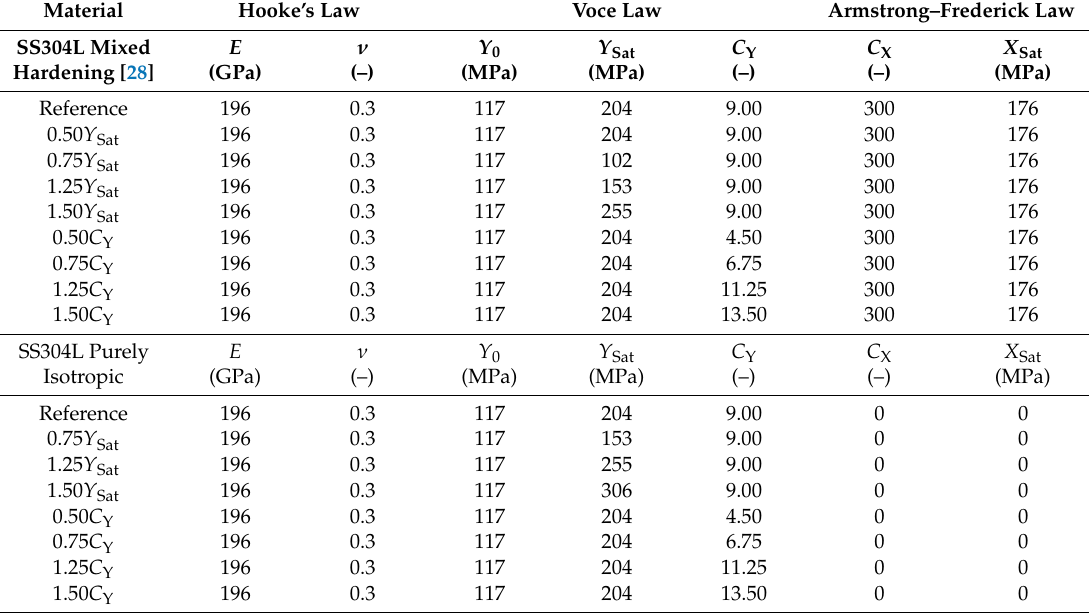
Table 2. The set of material